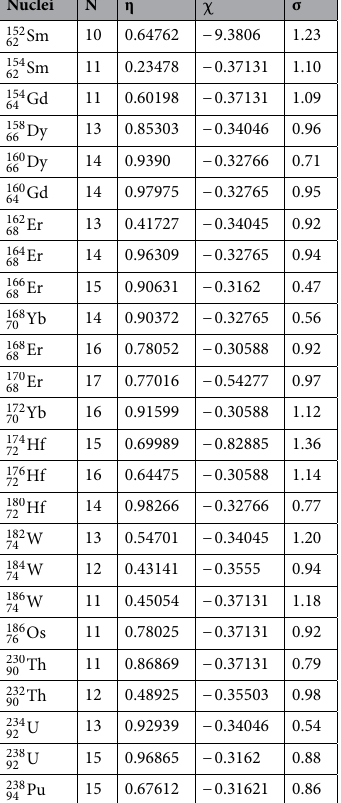
Table 3. Control parameter values for the regular nuclei candidates. σ describes the quality of extraction